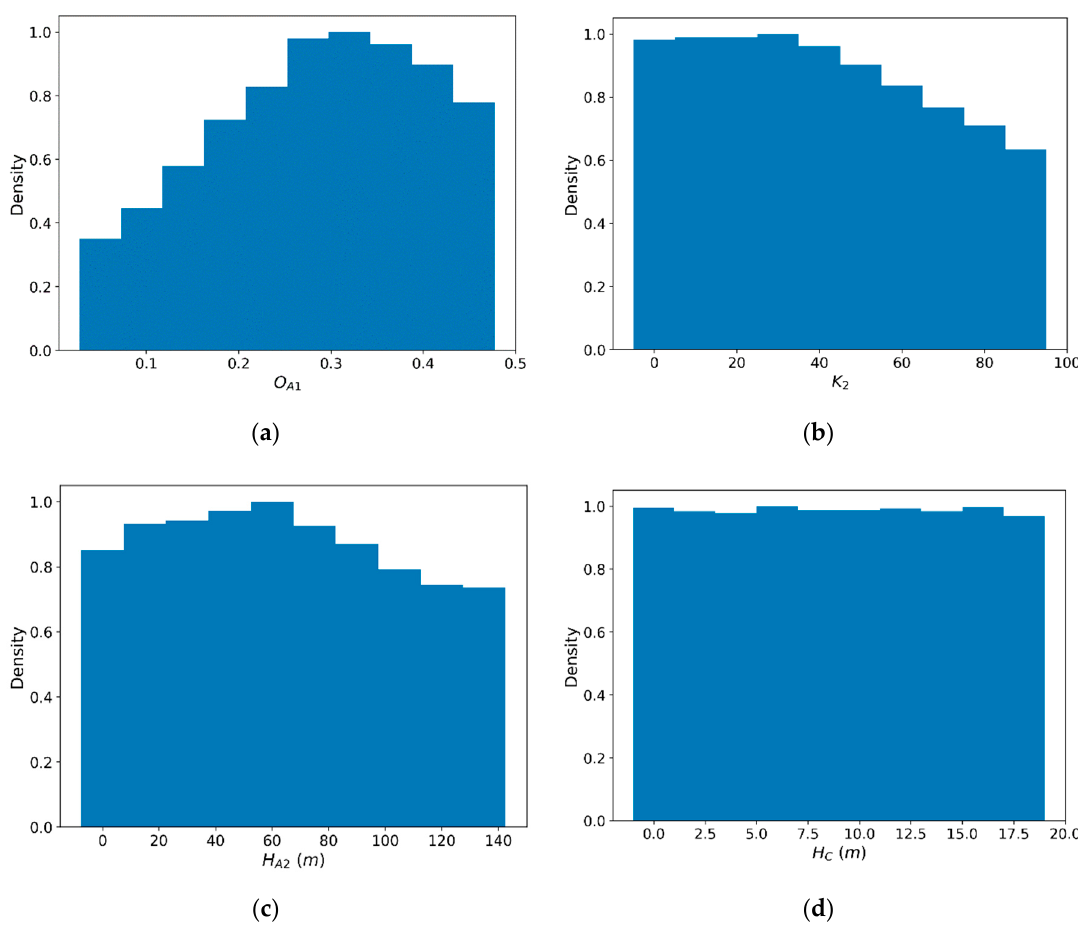
Figure 3. GLUE derived posterior distribution of parameters for Station 1,002,640 ( a ) O A 1 (outlet constraint of the lower outlet at Tank A , initially ranged from 0~0.5), ( b ) K 2 (soil moisture exchange rates between the top two tanks, initially ranged from 0~100), ( c ) H A 2 (storage level to the upper outlet at Tank A , initially ranged from 0~150 m) and ( d ) H c (storage level to the outlet at Tank C , initially ranged from 0~20